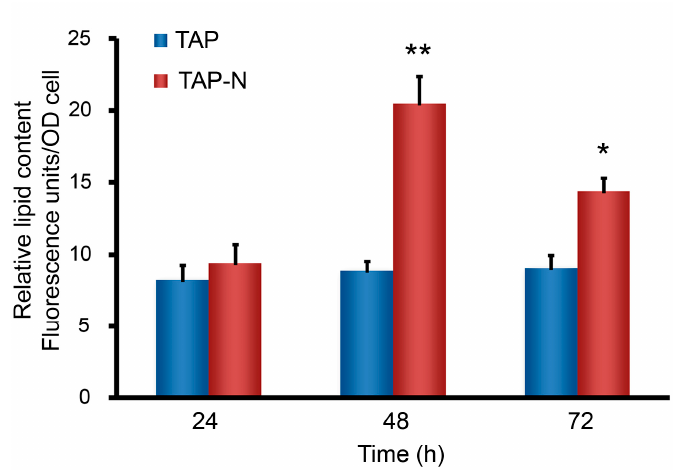
Figure 1. Lipid accumulation in nitrogen-deprived cells. C. reinhardtii cultures cultivated in nitrogen-replete medium (TAP) and nitrogen deficiency medium (TAP-N) were stained with Nile red on days 1, 2, and 3. Neutral lipid content was measured by determining Nile red fluorescence. * p < 0.05, ** p < 0.01 versus littermate controls by two-way ANOVA.